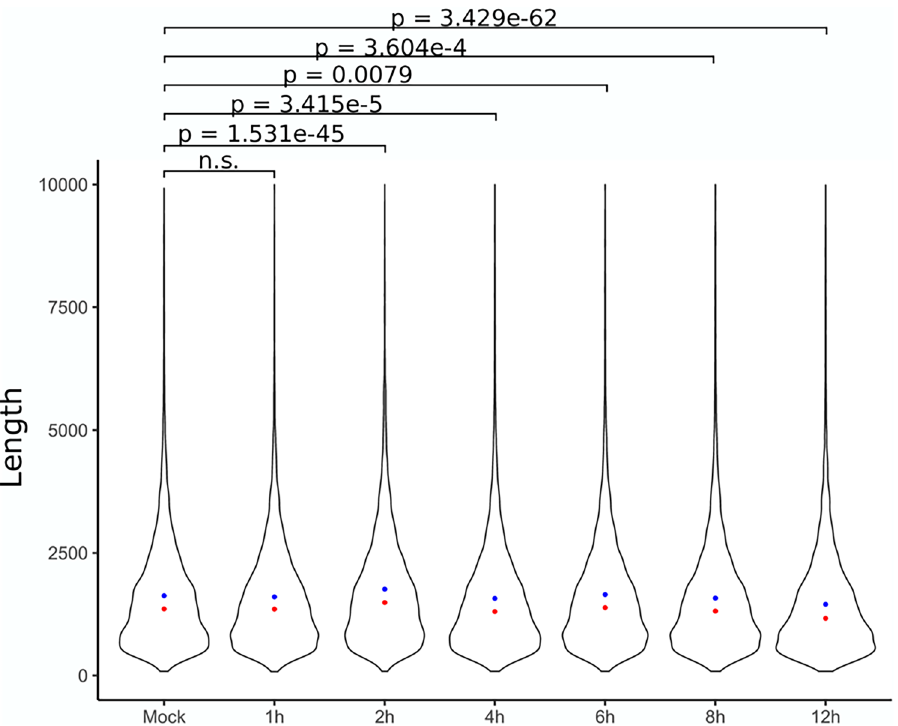
Figure 3. The length of polyadenylated bovine transcripts. Blue dots represent the median while red dots represent the mean of datasets. The figure was created using R v. 3.6.3 (https:// www.r- proje ct. org/) and ggplot2 v. 3.3.3 (https:// ggplo t2. tidyv erse. org/ refer ence/ ggplot. html) and Inkscape v. 0.92 (https:// inksc ape.